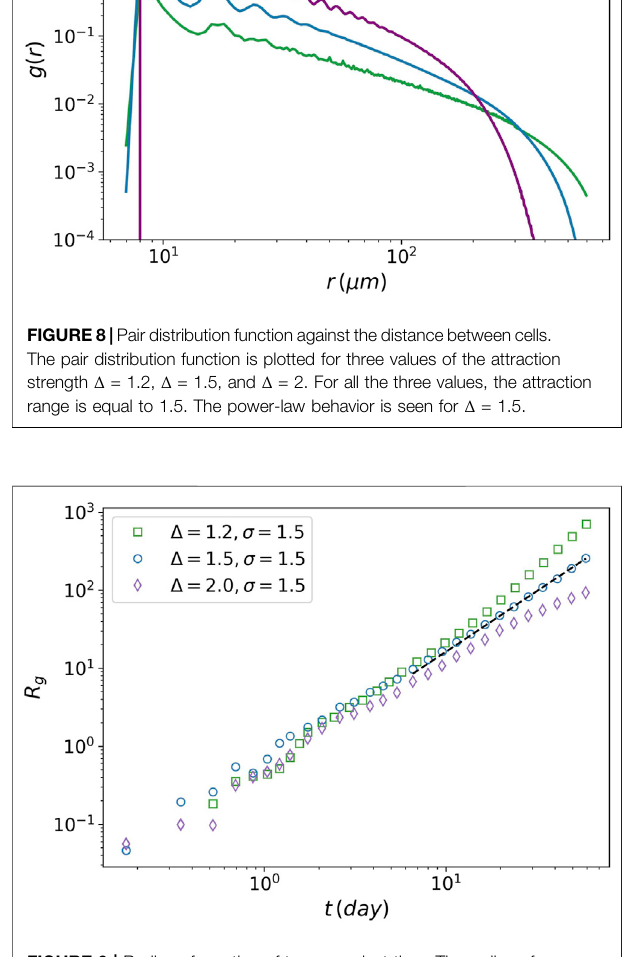
FIGURE 9 | Radius of gyration of tumor against time. The radius of gyration is plotted for three values of the attraction strength Δ = 1.2, Δ = 1.5, and Δ = 2. For all the three values the attraction range is equal to 1.5. The power-law behavior is seen for Δ = 1.5 (dashed